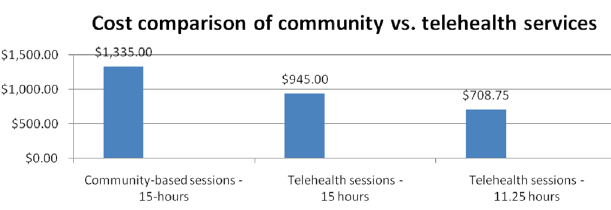
Figure 5 – Cost comparison of community vs. telehealth